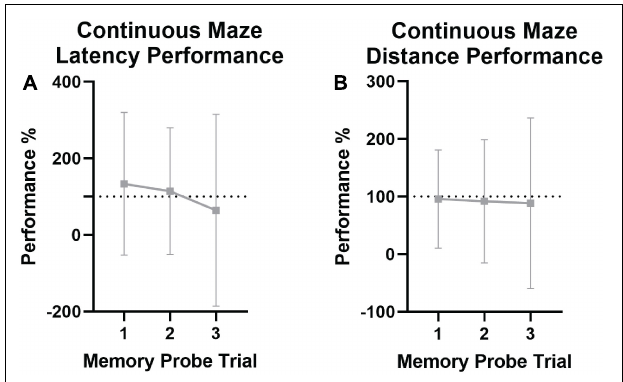
FIGURE 7 | Continuous spatial maze memory performance in naked mole-rats. Animals were tested for spatial memory retention at 1 day, 1 week, and 1 month (memory probe 1, 2, and 3, respectively) following training. Dashed lines indicate the point of equivalence for performance on the last training day. (A) Latency across memory probe trials, with memory probe trial latency performance shown as a percentage of the last trial on the last training day in the learning phase of testing. No significant differences were found, indicating spatial memory retention, although this could be skewed by the high variability present. (B) Total distance traveled across memory probe trials, with distance traveled during the indicated memory probe trial shown as a percentage of the distance traveled on the last trial of the last training day. No significant impairments in performance were noted across the three time